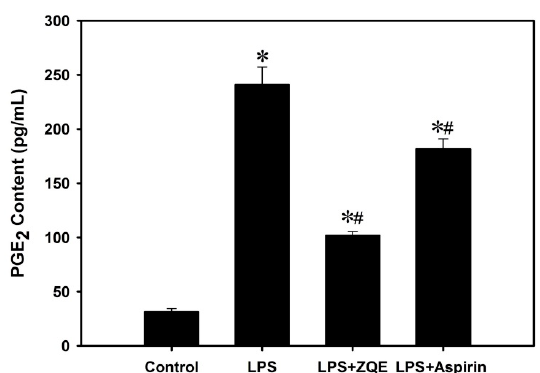
Figure 4. Effects of ZQE on the PGE 2 production in LPS-induced RAW 264.7 macrophages. The cells were pretreated with ZQE (250 μ g/mL) and aspirin (250 μ g/mL) in the presence of LPS (1 μ g/mL) for 12 h, and aspirin was used as a positive control. The production of PGE 2 in the supernatant were assayed using ELISA kits. The data shown are from three independent experiments and expressed as mean ± SD. * p < 0.05 and # p < 0.05 compared the control (with no LPS, ZQE, or aspirin) and LPS alone, respectively. LPS: lipopolysaccharide; PGE 2 : Prostaglandins E2; ELISA: enzyme-linked immunosorbent assay.